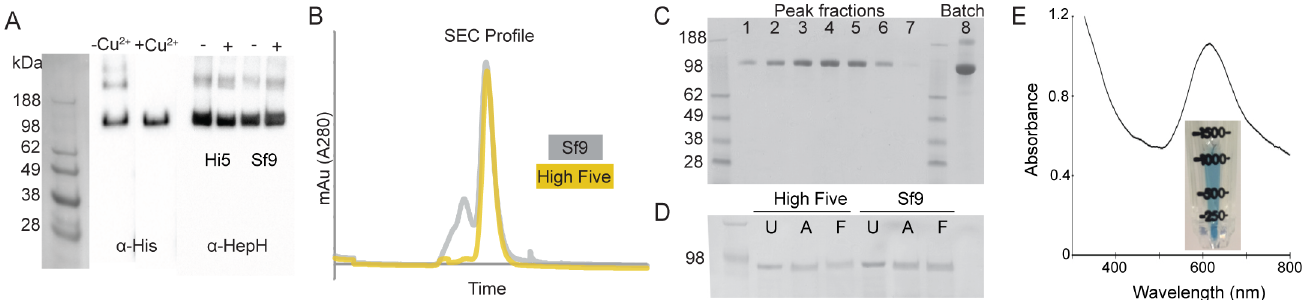
Fig 2. Purification of recombinant mouse HEPH. A , Western blot of purifiedsamples using antibodies directed againstthe C-terminal His-tag (left) and HEPH (right). Addingcopper sulfate to the culture media made no significantdifference when analysedby Western blotting. B , Size exclusion chromatograms of protein purifiedfrom Sf 9 and High Five cells. C , SDS-PAGE of peak fractions (lane 1–7) from size exclusionchromatography. Lane 8 is concentrated protein from batch purification. D , SDS-PAGE analysisof endoglycosidase treatment of purifiedHEPH protein from High Five and Sf 9 cell expression. U = untreated, A = PNGase A, F = PNGase F. E , Concentrated protein had a distinct blue colour from the copper content of the protein, which had an absorbance peak at 611 nm.